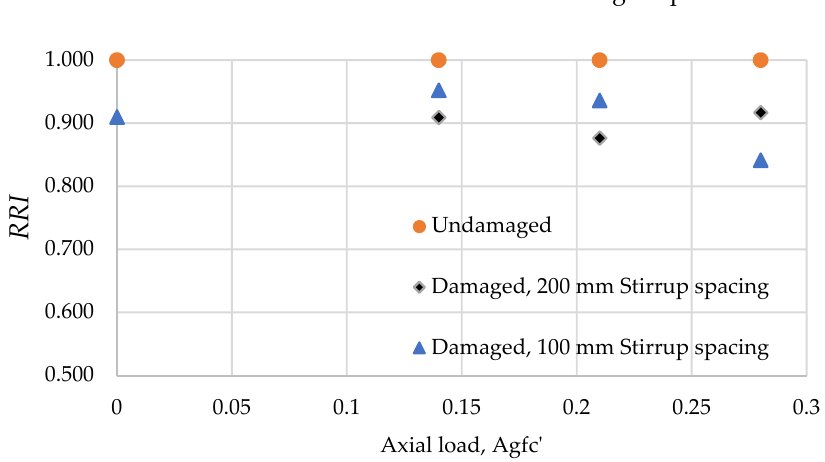
Figure 9. Residual Resistance Index with different axial loads.